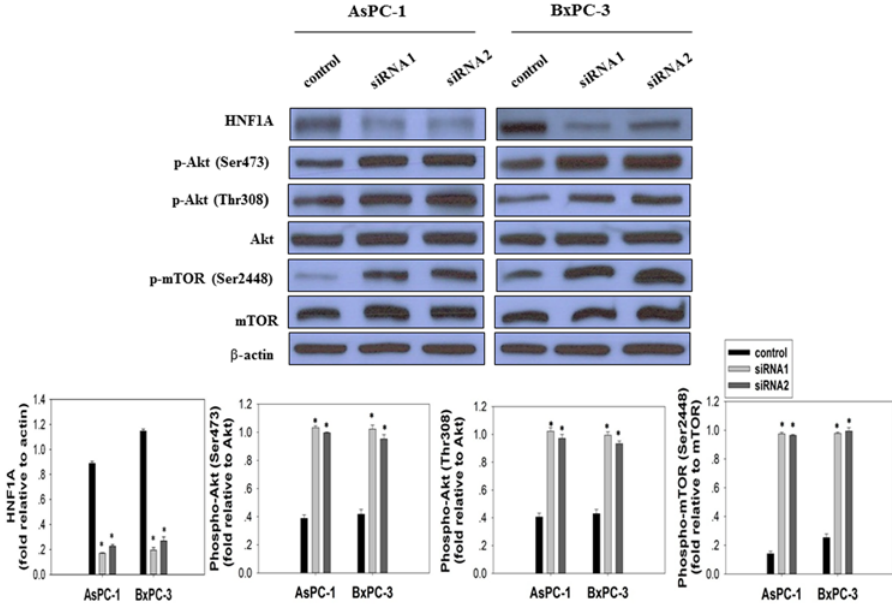
Fig 6. Effect of HNF1A knockdown on AKT/mTOR signaling pathway was assessed by Western Blot. AsPC-1 and BxPC-3 cells were transfected with control siRNA and two different HNF1A siRNAs as indicated. 96h after transfection, cell lysates were immunoblotted with anti- HNF1A antibody, anti-phospho-AKT Ser473 antibody, anti-phospho-AKT Thr308 antibody, and anti-phospho-mTOR Ser2448 antibody. Membranes were stripped and re-probed with anti-AKT antibody, anti-mTOR antibody and anti- β -actin antibody. The fold differences in protein expression levels of cells transfected with HNF1A siRNA and control siRNA was presented as mean ± SD from three independent